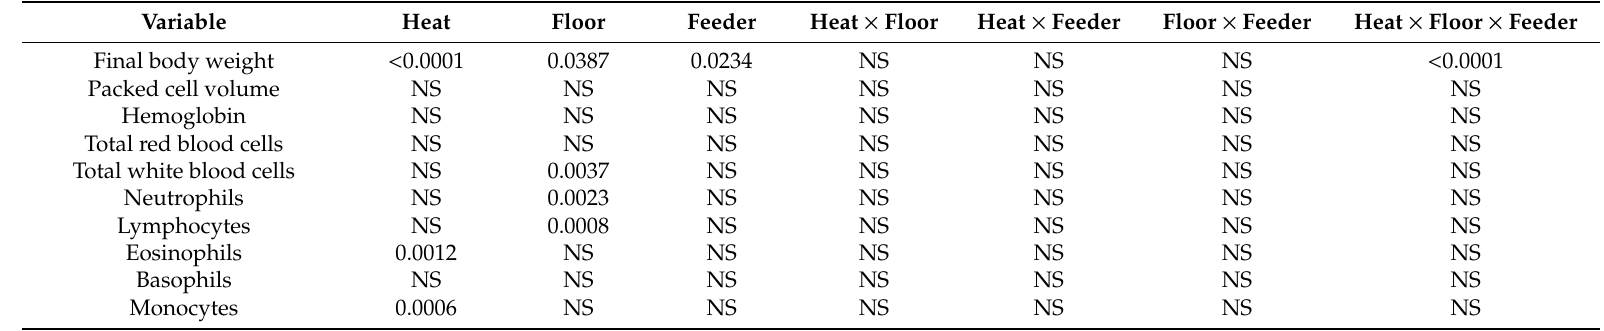
Table 2. Results of the statistical analysis of the di ff erent variables considered in the study, where heat is related to the e ff ect of temperature (heated room vs. control room), floor to the type of floor (30% slat 70% concrete vs. 100% slat), and feeder to the number of feeders per pen (one: single; two: double), and all the possible double (heatxfloor, heatxfeeder and floorxfeeder) and triple (heatxfloorxfeeder)